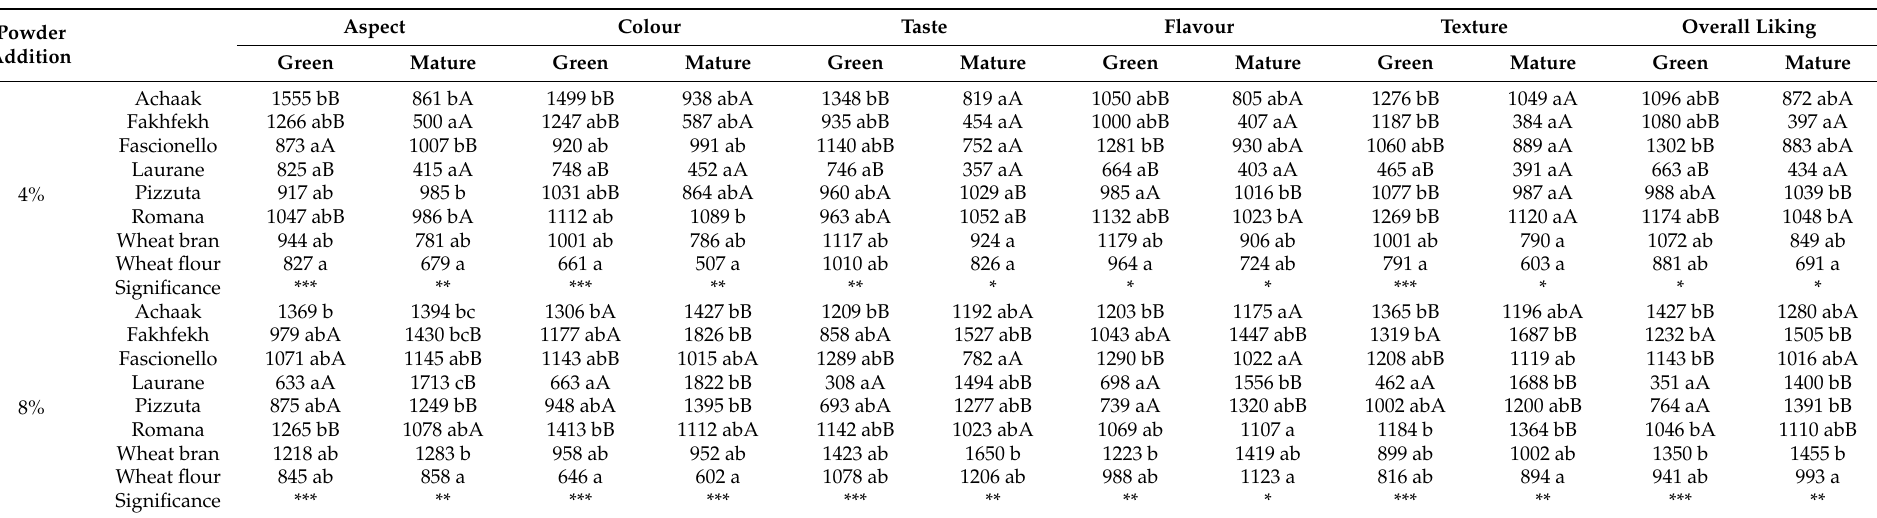
Table 10. Sum of the ranks for each parameter evaluated for the breads during the consumer tests and results of Kruskal–Wallis tests performed on the sum of the rank.